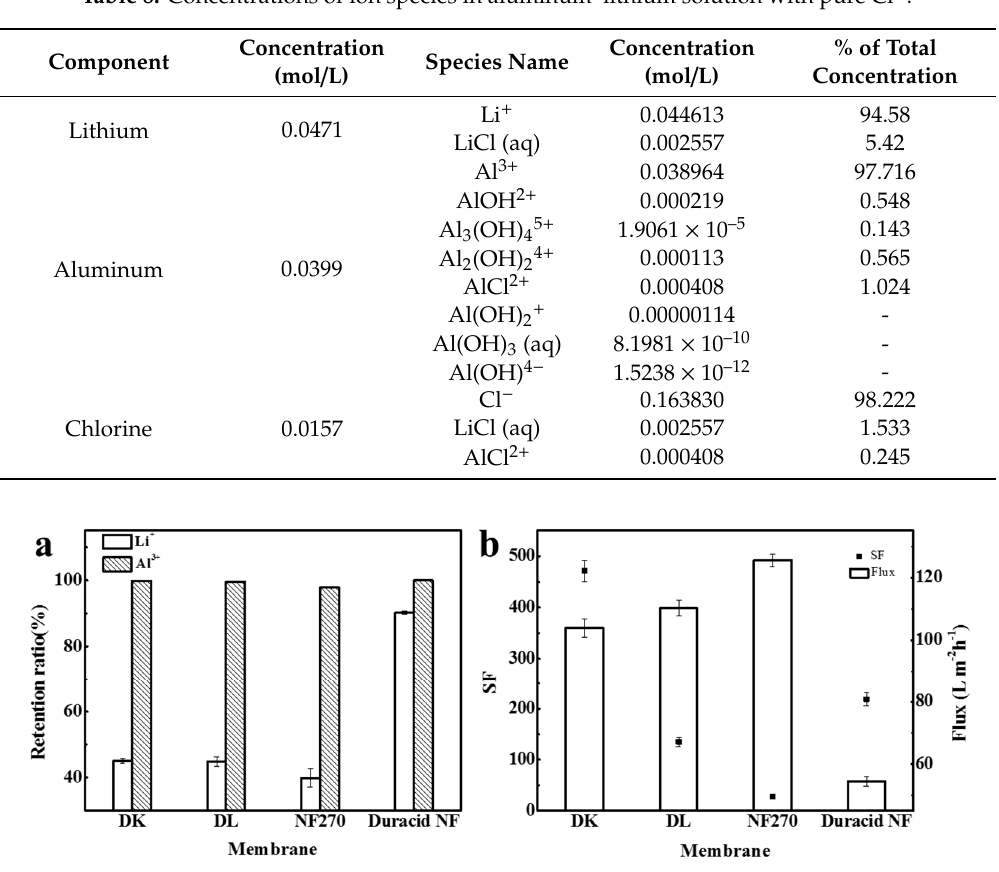
Table 8. Concentrations of ion species in aluminum–lithium solution with pure Cl − .